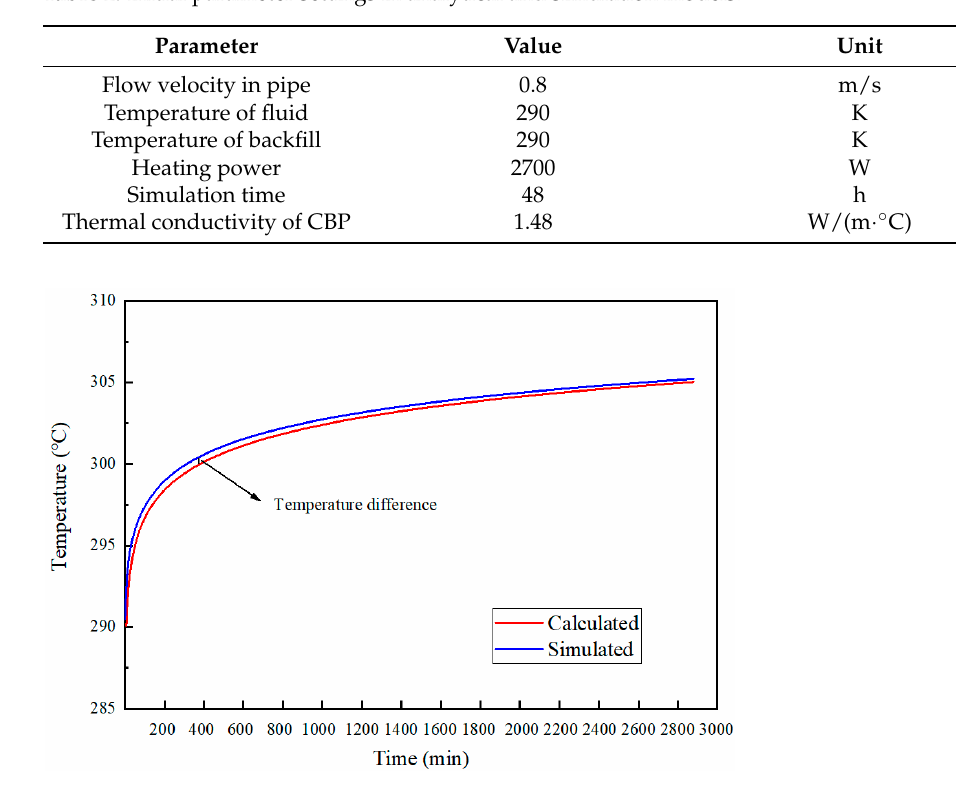
Table 2. Initial parameter settings in analytical and simulation models.